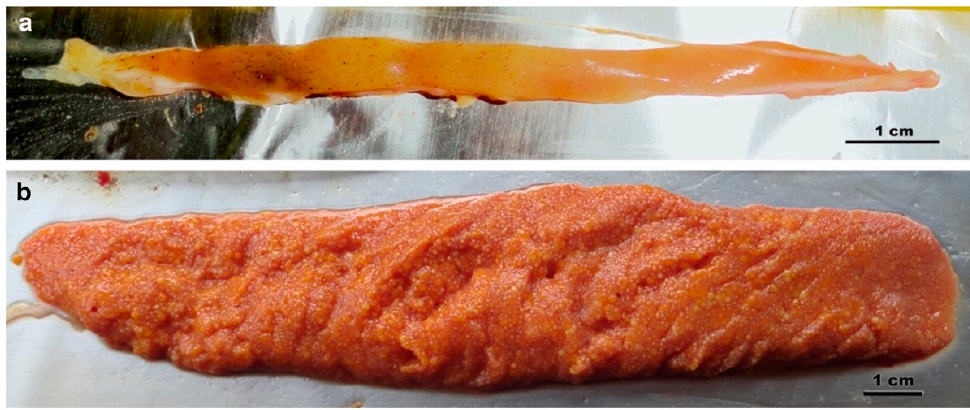
Figure 1. Macroscopic aspects of the testis ( a ) and ovary ( b ) of sexually mature male and female African bonytongue, Heterotis niloticus , respectively. Scale bars, 1 cm.